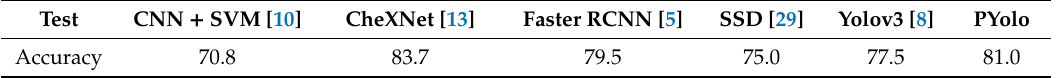
Table 10. Classification accuracy of di ff erent algorithms